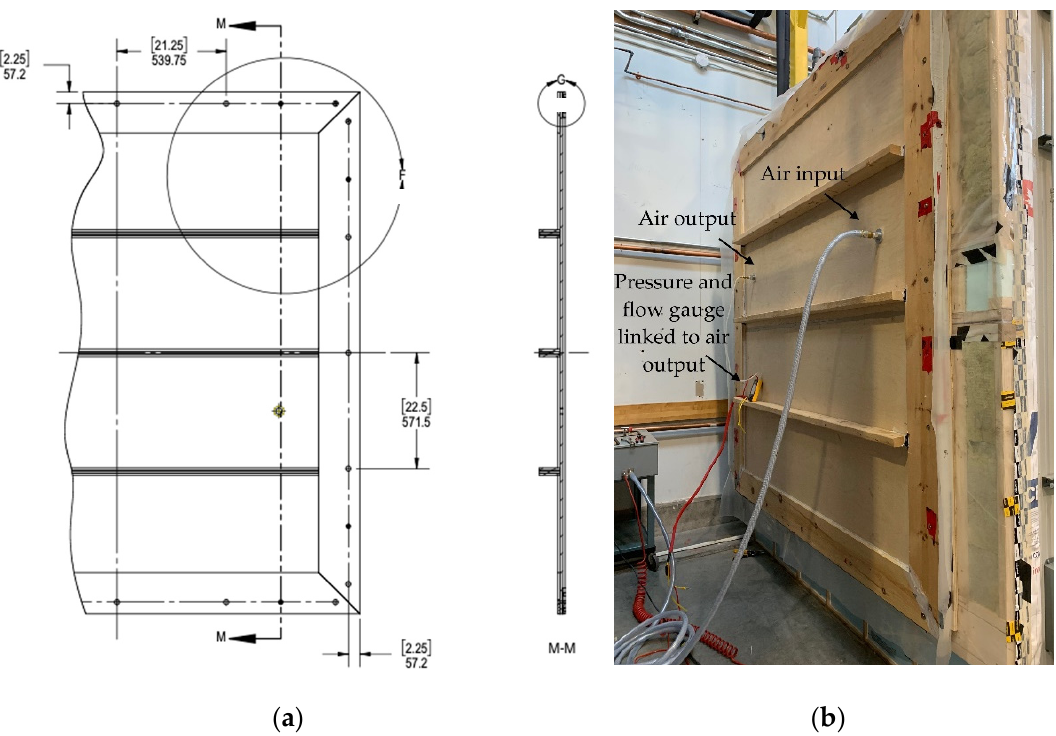
Figure 5. Test gauge ( a ) applied against an experimental wall for an airtightness assessment ( b ).